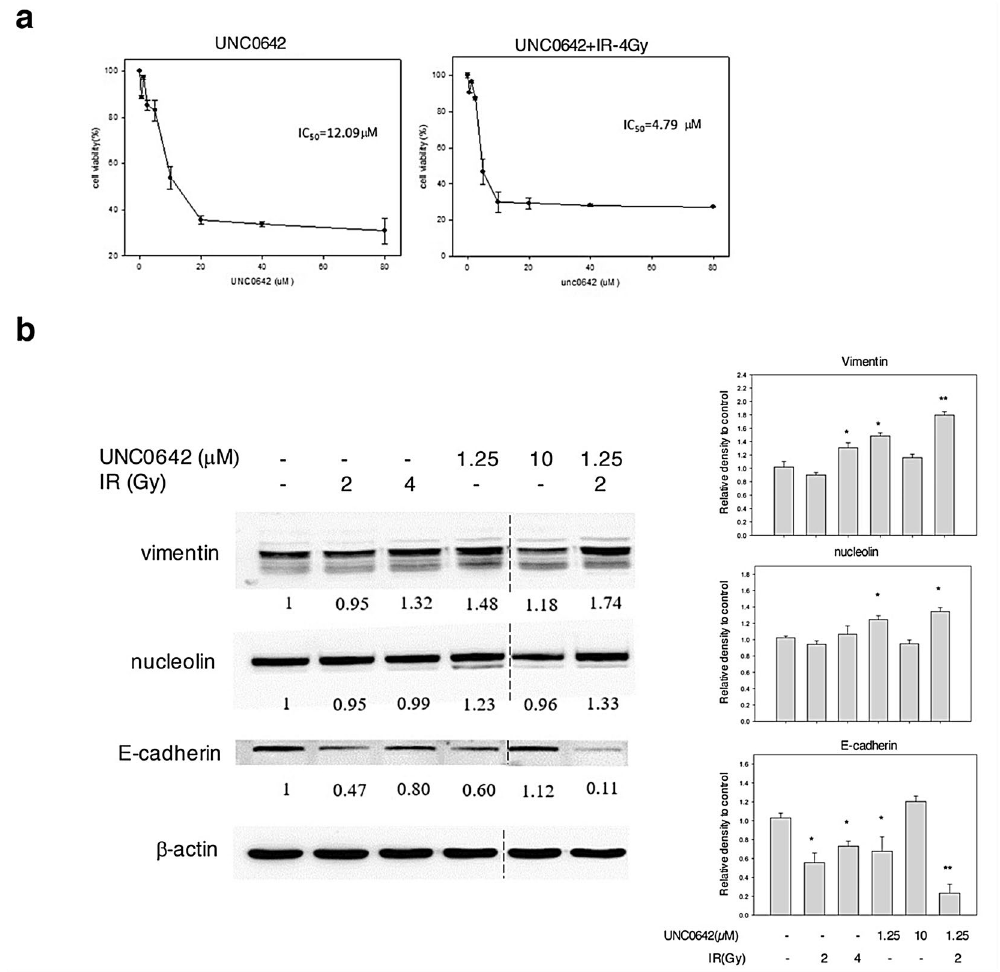
Figure 3. In vitro induction of EMT and stemness with Unc0642/IR. ( a ) SAS cells were treated with indicated concentration of Unc0642 and Unc0642 + 2 Gy of radiation for 72 h respectively. Cell viability was assessed by AlamarBlue assay. All data were normalized to cells without treatment. Data are presented as mean ± SD. IC 50 was calculated using SigmaPlot12 software. ( b ) Western blot analysis of CSC and EMT markers in SAS cells treated with different concentration of Unc 0642 (1.25 and 10 µM) and different dose of radiation (2 and 4 Gy) respectively. Internal control: b-actin. Right graph: the quantification of protein expression levels normalized against b-actin levels in each sample. * p < 0.05; ** p < 0.01 by Student’s t -test. The blots were cropped from different parts of the same gel. The original blots and all replicates are presented in Supplementary Fig.